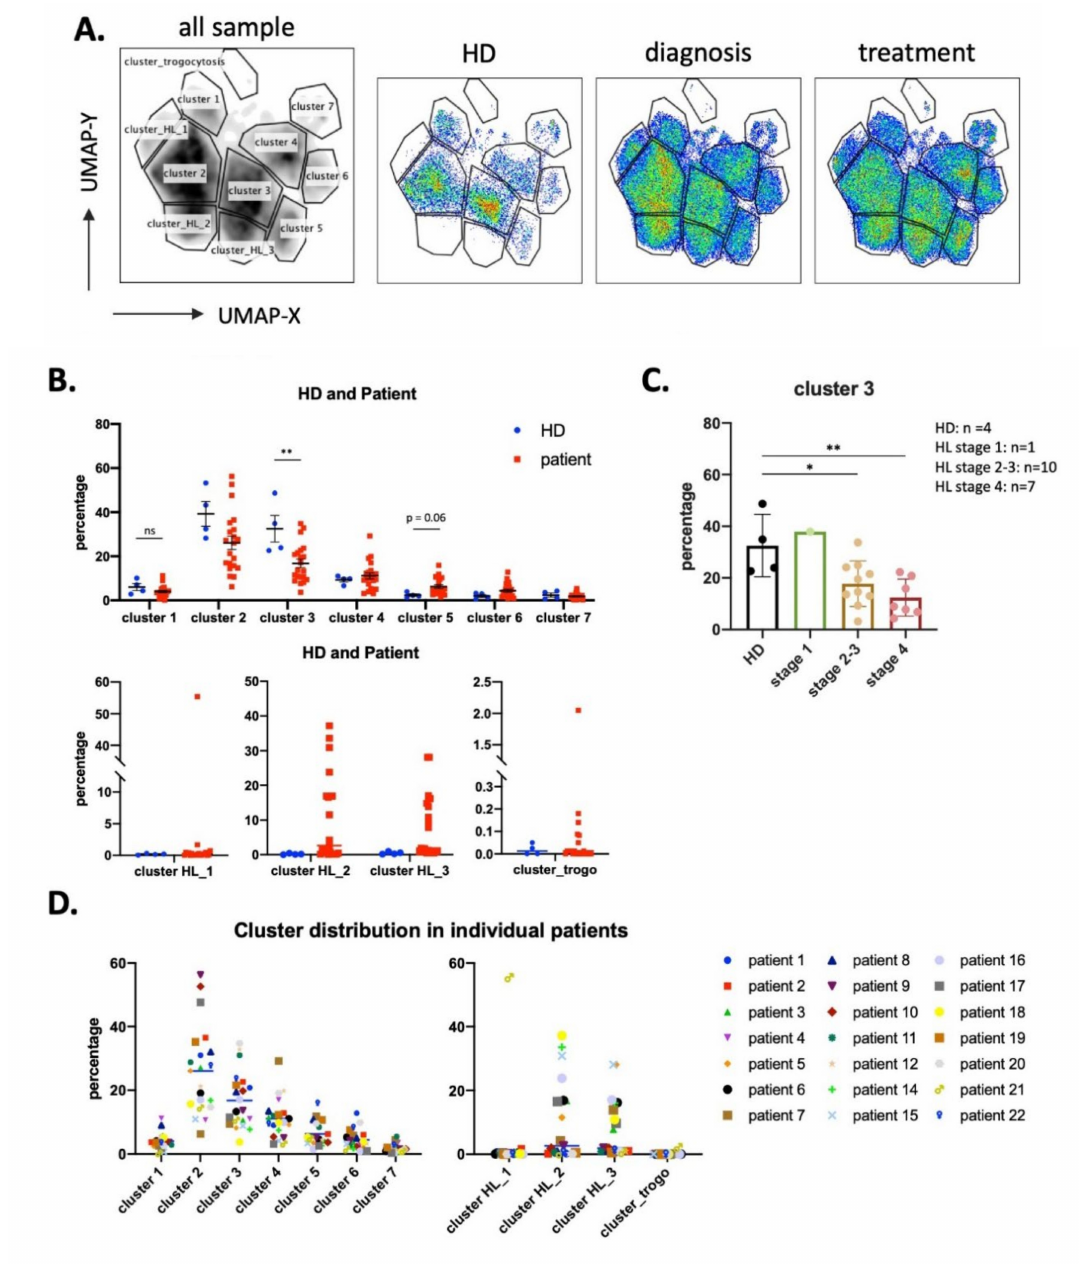
Figure 3. Identification of NK cell clusters in HL patients via Uniform Manifold Approximation and Projection (UMAP). Four thousand representative NK cells from HD ( n = 4) and HL patients ( n = 21, 2 timepoints per patient (diagnosis and treatment); total n = 46) were combined to generate an UMAP embed from expression level of 14 surface markers. ( A ) Original UMAP plot of all samples and daughter maps from HD, HL patients at diagnosis, and HL patients after treatment. ( B ) Each cluster was assigned an annotation and subsequently quantified in each HD and patient. ( C ) Proportion of cluster 3 plotted against HD and various HL stages. ( D ) Cluster quantification as shown in B with patient ID labelled. Statistical significance determined by unpaired t-test, n = 21, * p ≤ 0.05, ** p ≤